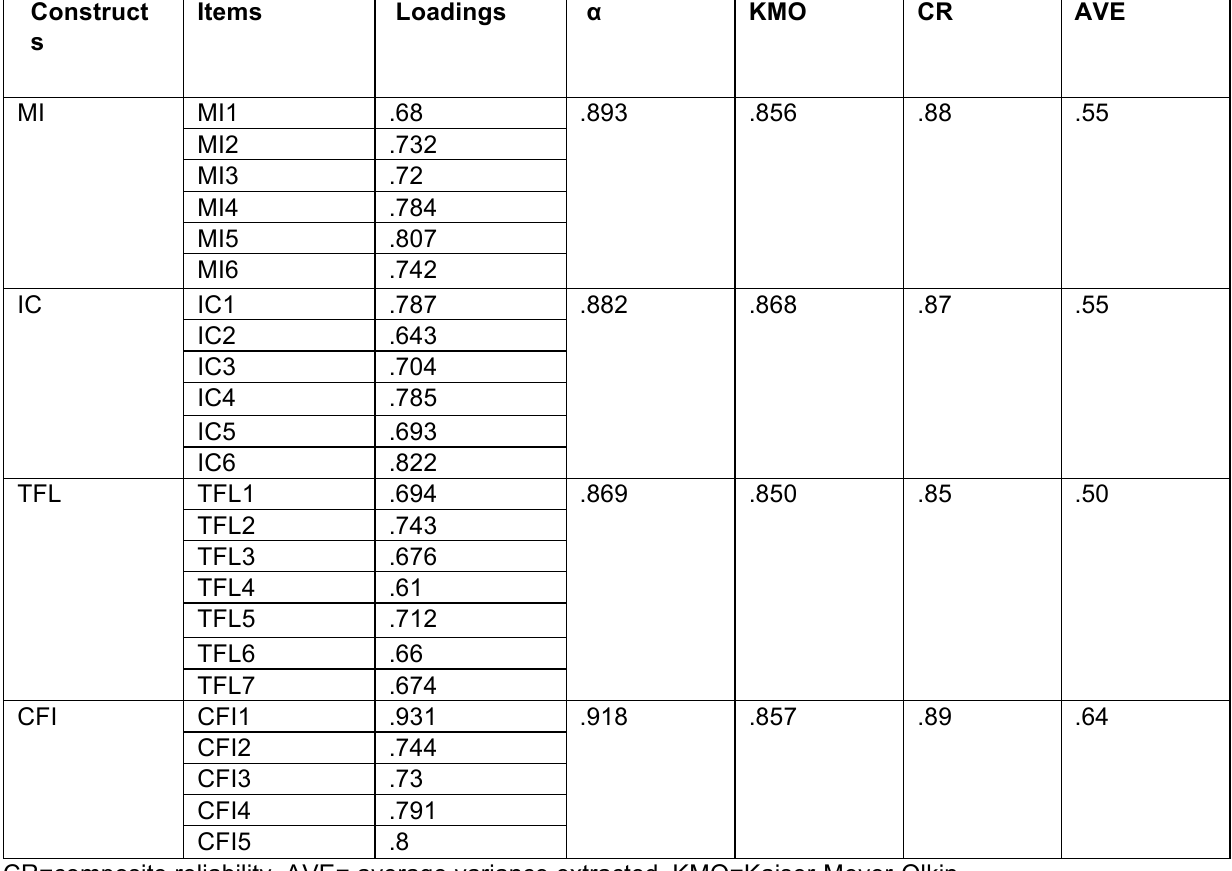
Table 2: Findings on the measurement model